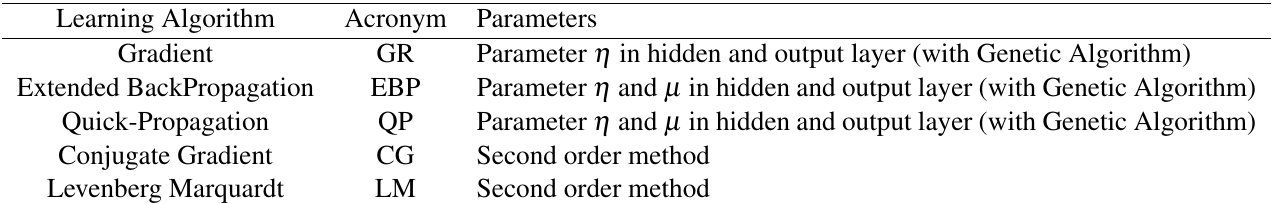
Table 4: Stage 4. List of Learning